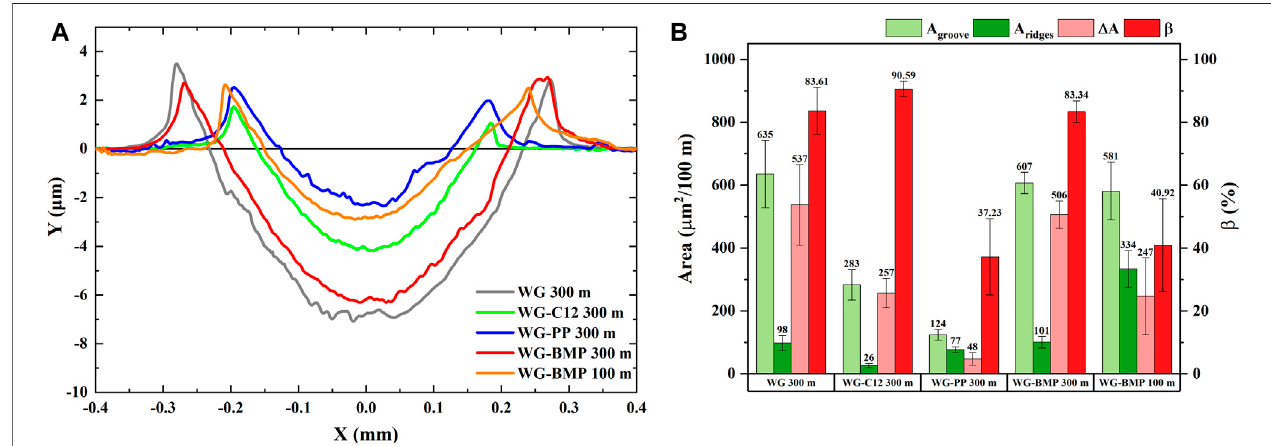
FIGURE 7 | Wear cross-section pro fi les (A) and calculated area of Panel (A) (B) of AISI 52100 steel tested in different lubricants at room temperature.